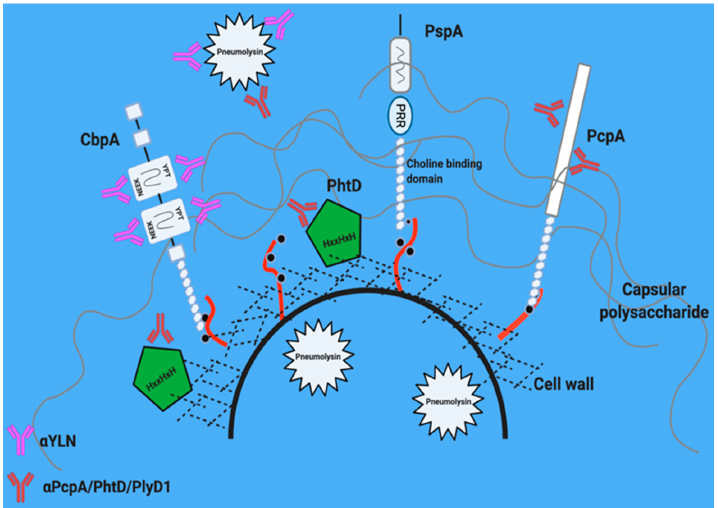
Figure 2. Leading candidate proteins for multi-valent vaccines . There are several conserved bacte- rial proteins—both on the surface of the cell wall (hatched black lines with red teichoic acids) and present in the extracellular environment of the bacteria. Pneumolysin (white star) is a pore form- ing toxin that is localized within the cytoplasm, but is released during cell lysis. Pneumococcal surface protein A (PspA), choline binding protein (CbpA), pneumococcal choline binding protein (PcpA) and histidine triad protein D (PhtD) are surface proteins that have domains conserved across serotypes and contribute to pneumococcal pathogenesis. Antibodies (pink and red Y shapes) targeting each of these proteins have been shown to convey protection to animals against experimental disease. Thus, they have been formulated into vaccines for human clinical trials.